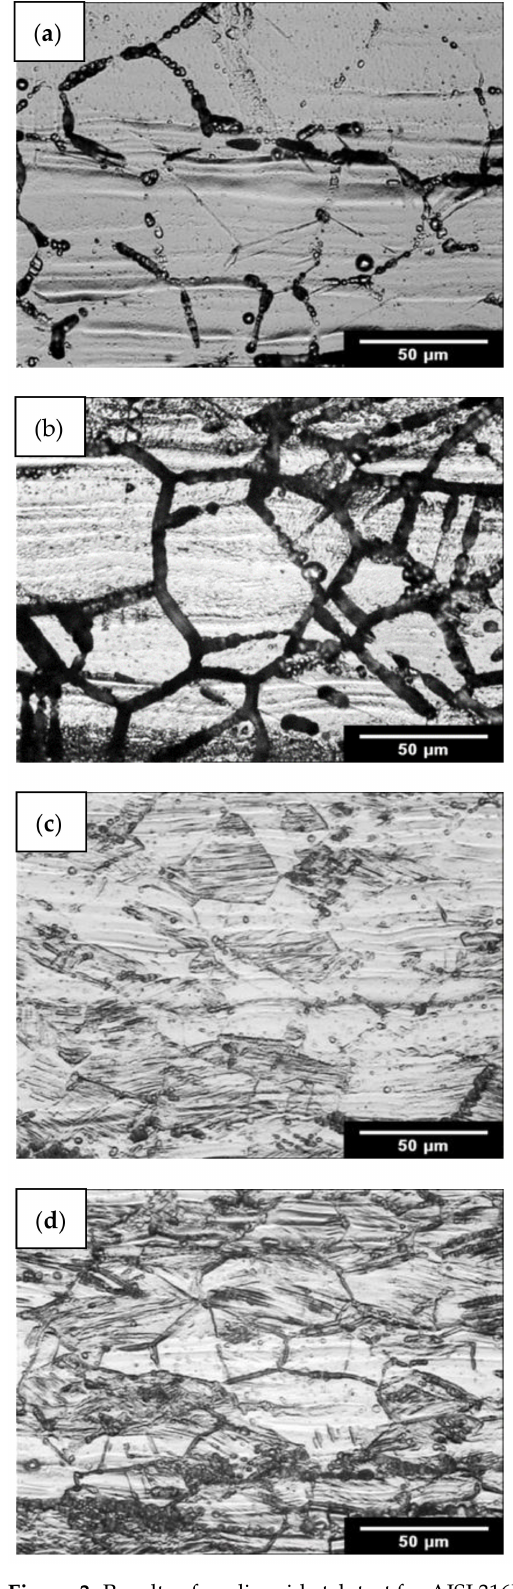
Figure 3. Results of oxalic acid etch test for AISI 316L: ( a ) AISI 316L (0% CW) dual structure observed in 650 ◦ C/10 h conditions; ( b ) AISI 316L (0% CW) ditch structure observed in 650 ◦ C/1000 h conditions; ( c ) AISI 316L (40% CW) dual structure observed in 650 ◦ C/1 h conditions; ( d ) AISI 316L (40% CW) ditch structure observed in 650 ◦ C/10 h